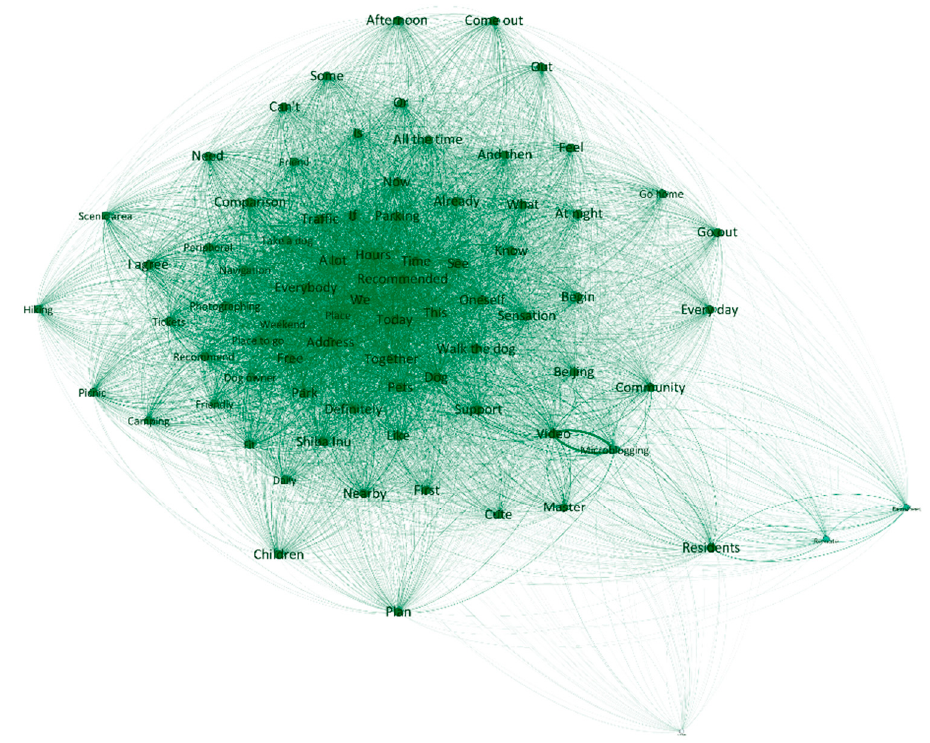
Figure 6. Semantic network diagram (before the outbreak).